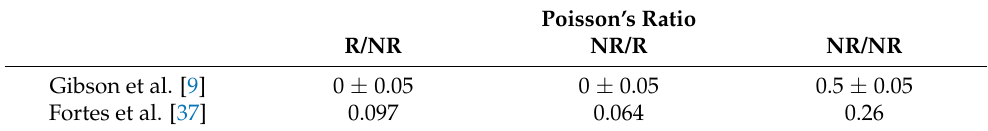
Table 4. Natural cork Poisson’s